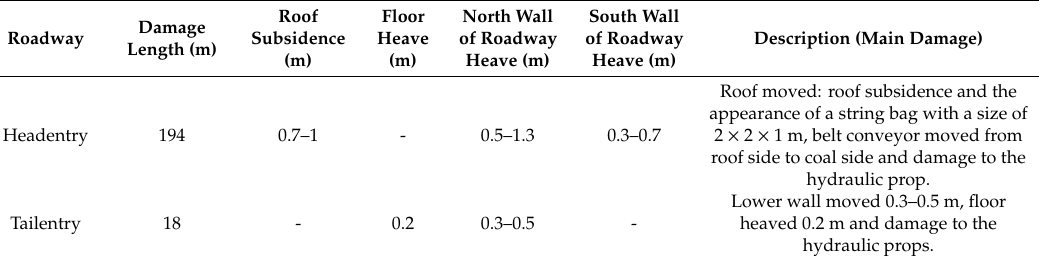
Table 3. Damage type and scope of rockburst that occurred on 1 February 2017.